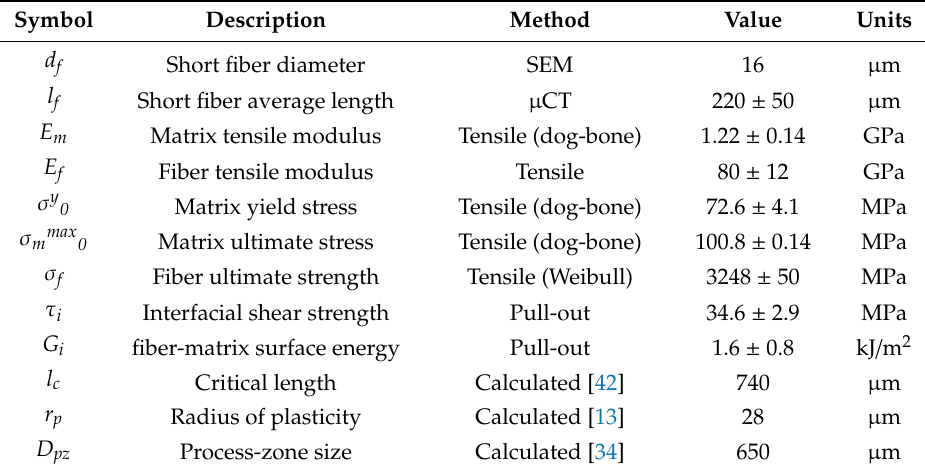
Table 4. Composite Properties.